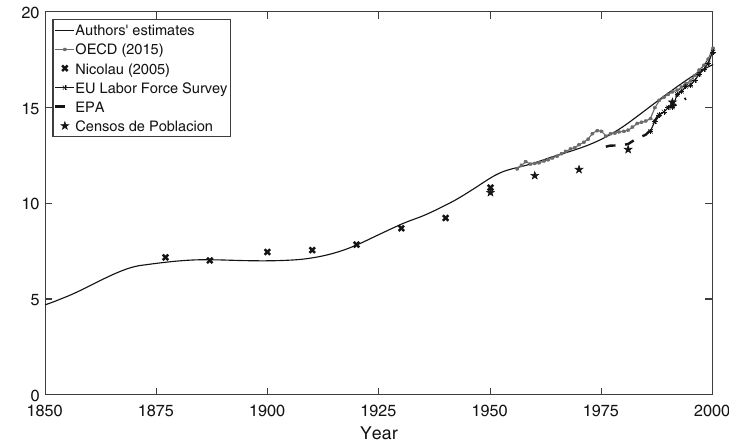
Fig. 5 Labor force, Spain 1850–2000 (both sexes combined, in